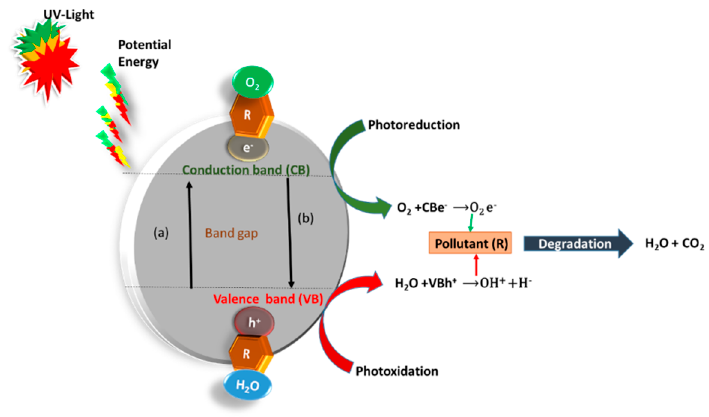
Figure 3. Schematic presentation of the photocatalysis mechanism; adapted from [26]. The electrons extracted from the VB are passed to the CB, which then react with the absorbed oxygen ( O 2 ) on the TiO 2 surface. As a result, a positive area ( h + ) forms in the VB holes and causes free electrons ( e − ) to form in the CB . Simultaneously, the holes ( h + ) react with water molecules ( H 2 O ) adsorbed on the TiO 2 surface to create hydroxyl radicals ( OH ), as shown in Figure 3 and Equations (1)–(4). Furthermore, the CB electron reduces oxygen to superoxide ions ( O 2 •− ). This reaction prevents the e − / h + from recombining, which happens when other electron acceptors such as pollutants are absent [30,40]. Organic pollutants ( R ) in wastewater can be oxidized to carbon dioxide ( CO 2 ) and water ( H 2 O ) by oxygen reactive radicals.